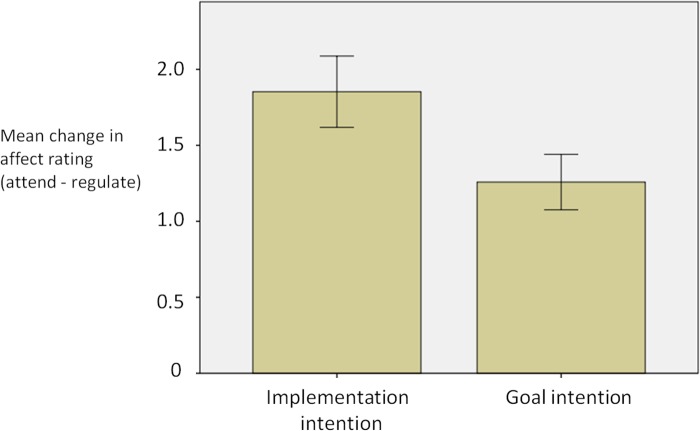
Mean change in affect ratings (and standard error) as a function of emotion regulation for the two groups.A greater mean change in affect rating is indicative of more successful emotion regulation (i.e. a larger reduction in affect ratings for the emotion regulation compared to not regulating emotion).